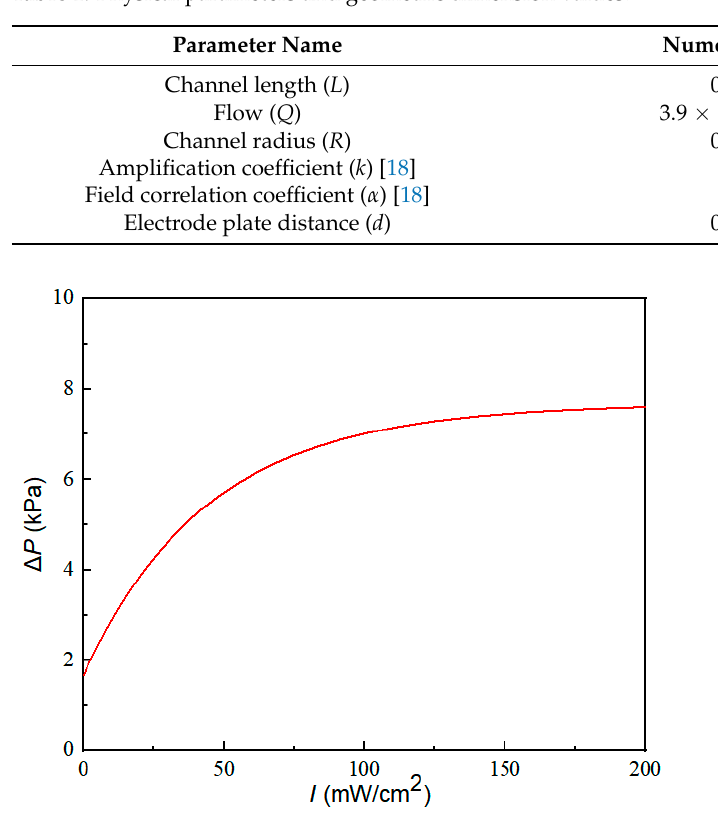
Table 1. Physical parameters and geometric dimension values.